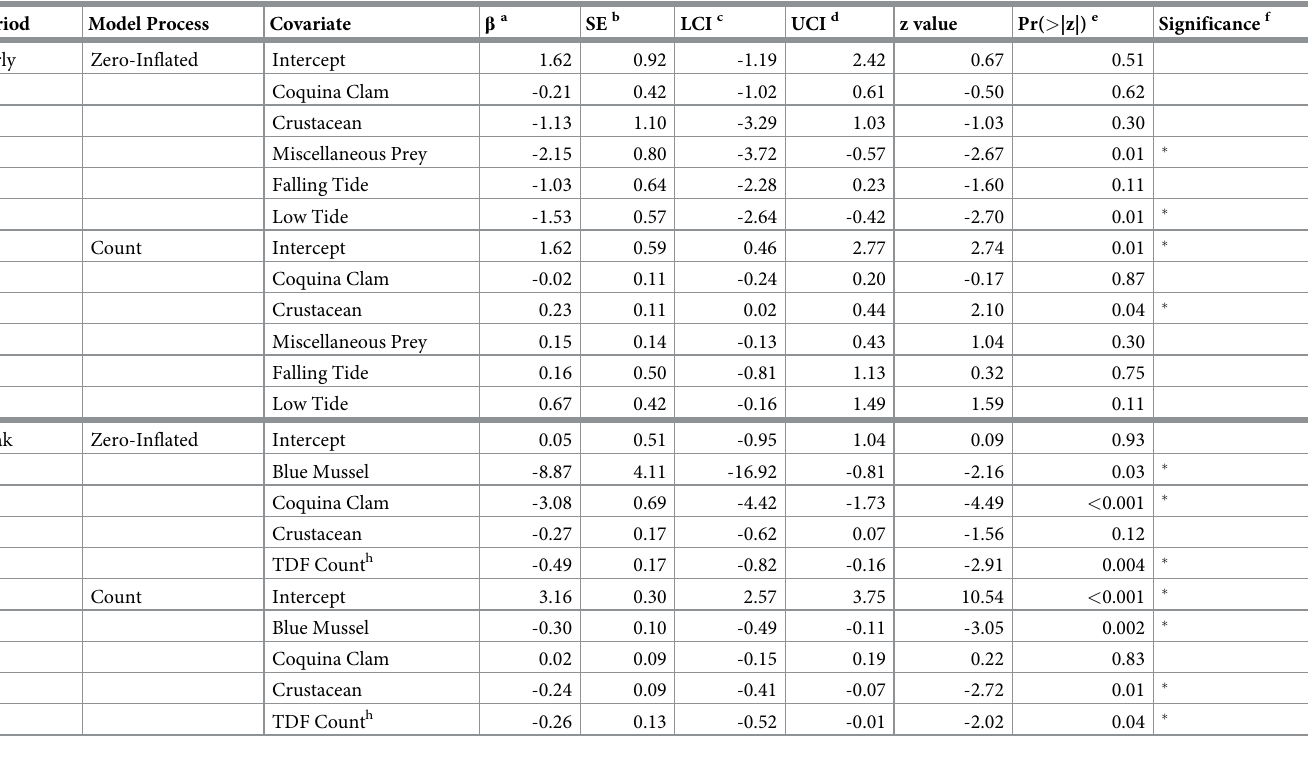
Table 2. Parameter estimates ( β ) from the most parsimonious zero-inflated negative binomial mixed-effect regression models predicting red knot presence (zero- inflated process) and flock size (count process) on peat substrate early in red knot migration (May 14–20, 2008–2018, except 2010; n = 457; ‘early’), and on sand and peat substrates near the peak of red knot migration (May 21–27, 2007–2018; n = 1,322; ‘peak’), Virginia’s barrier islands. All models contained “Island” and “Year” as random effects. Period Model Process